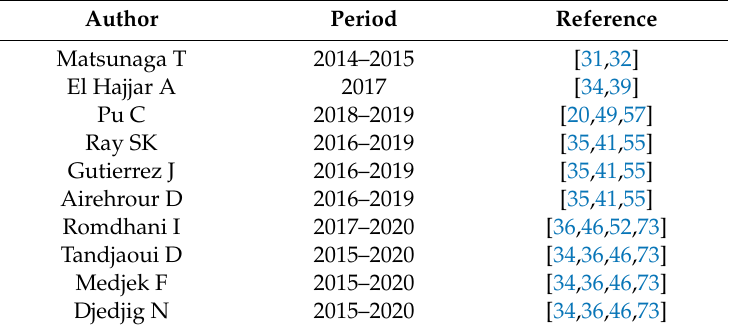
Table 10. Main Authors and Publication